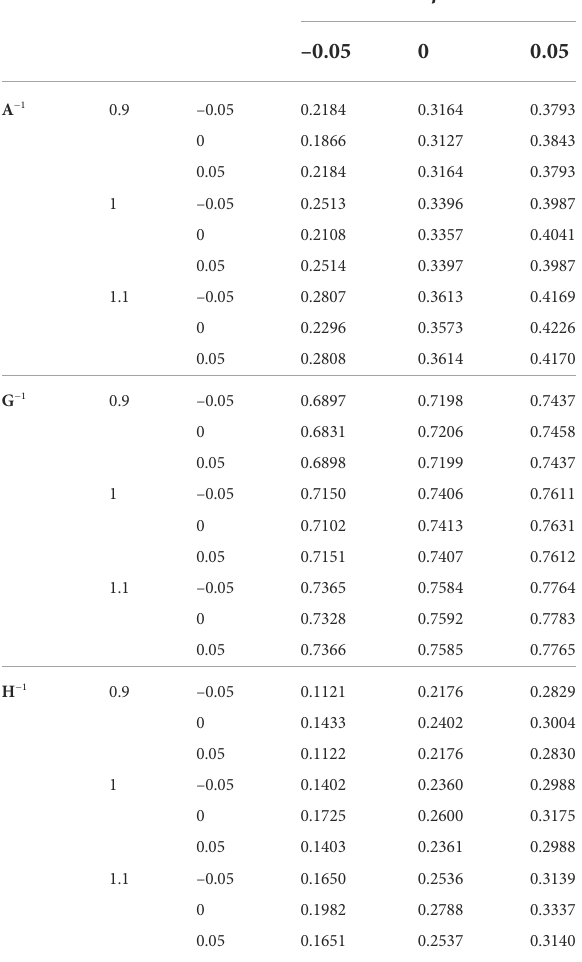
TABLE5Theeffectof w , α ,and β ( w K − 1 + α 11 ′ + β I)onthecorrelationof predicted breeding values with those using the original K − 1 ( w = 1, α = 0, and β = 0). The same heritability (based on the original K − 1 ) was used in all the